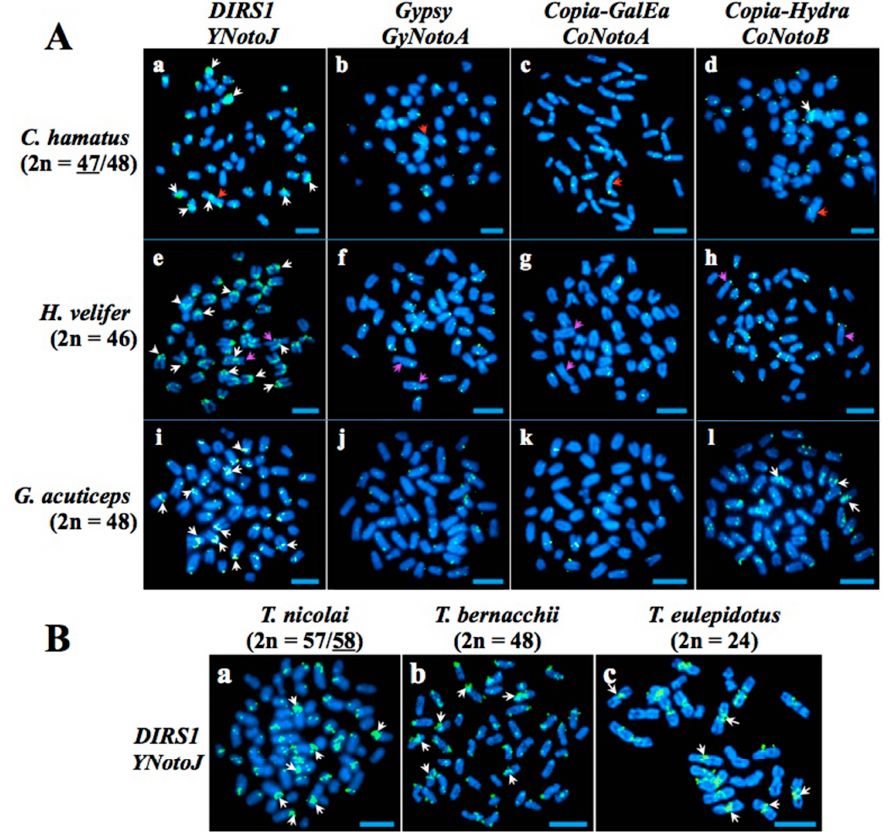
Figure 3. Fluorescent in-situ hybridization (FISH)-mapping of TEs on the chromosomes of six nototheniid species. ( A ) YNoto , GyNoto and CoNoto positioning in three non Trematomus Nototheniidae, ( B ) YNoto positioning in three Trematomus species. The chromosomal numbers of C. hamatus and T. nicolai are sex dependent. The number for the sex represented in the figure (male for C. hamatus , female for T. nicolai ) is underlined. Each probe was labeled with biotin and bound probes were detected with incubation with Avidin-FITC (fluorescein, greenish spots). Probe characteristics are indicated in Table S3. Chromosomal DNA was counterstained with 4 (cid:48) ,6-diamidino-2-phenylindole (DAPI). One family from each retrotransposon superfamily is represented in this figure for YNoto ( YNotoJ ) and GyNoto elements ( GyNotoA ), and two families for CoNoto elements ( CoNotoA ( GalEa clade) and CoNotoB ( Hydra clade)). Examples of TE distributions for pattern 1: a, e, i; pattern 2: j, h; and pattern 1 + 2: d, l. White arrows point examples of TE accumulations. Red arrows point the heteromorphic Y sex chromosome in C. hamatus and purple arrows indicate the largest sub-metacentric pair in H. velifer . Scale bars: 10 µ m.